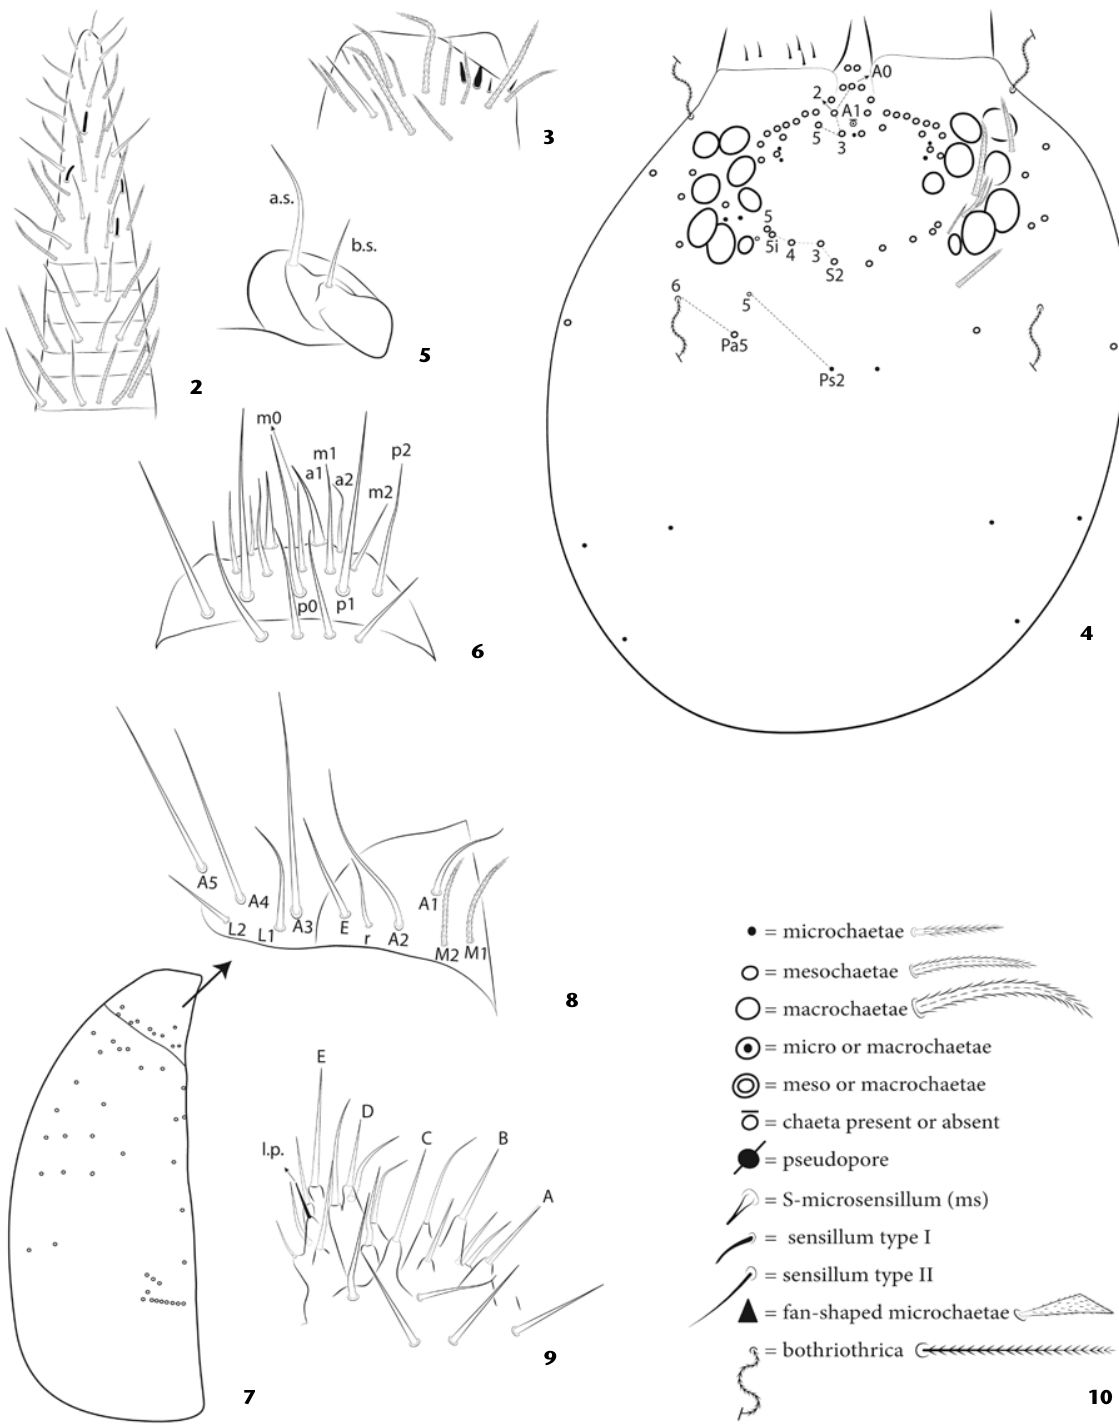
6Figures 2-10 . Campylothorax viruaensis sp. nov. : (2) antenna IV; (3) antenna III; (4) head dorsal chaetotaxy; (5) maxillary palp; (6) prelabral and labral chaetotaxy; (7) head ventral chaetotaxy; (8) labial region (left); (9) labial palp; (10) symbols used in detailed chaetotaxy ZOOLOGIA 33(3): e20160013 | DOI: 10.1590/S1984-4689zool-20160013 | July 14, 2016 3 /